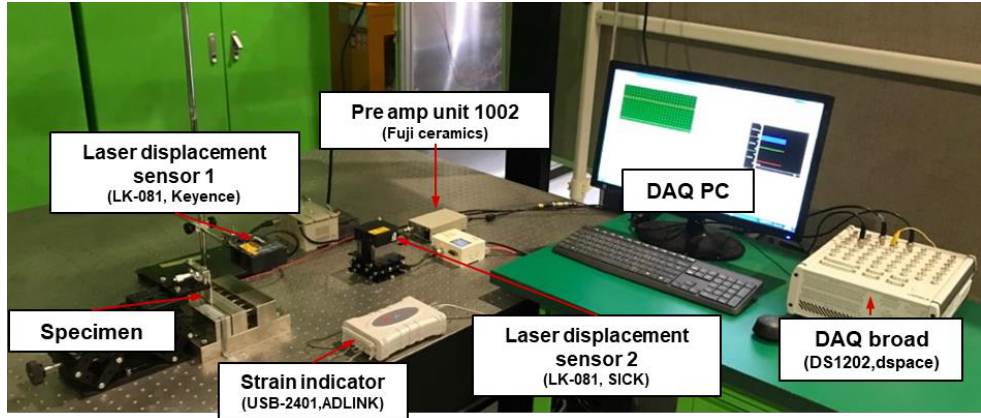
Figure 11. Test setup for deformation and strain estimation experiment for the multilayer beam.